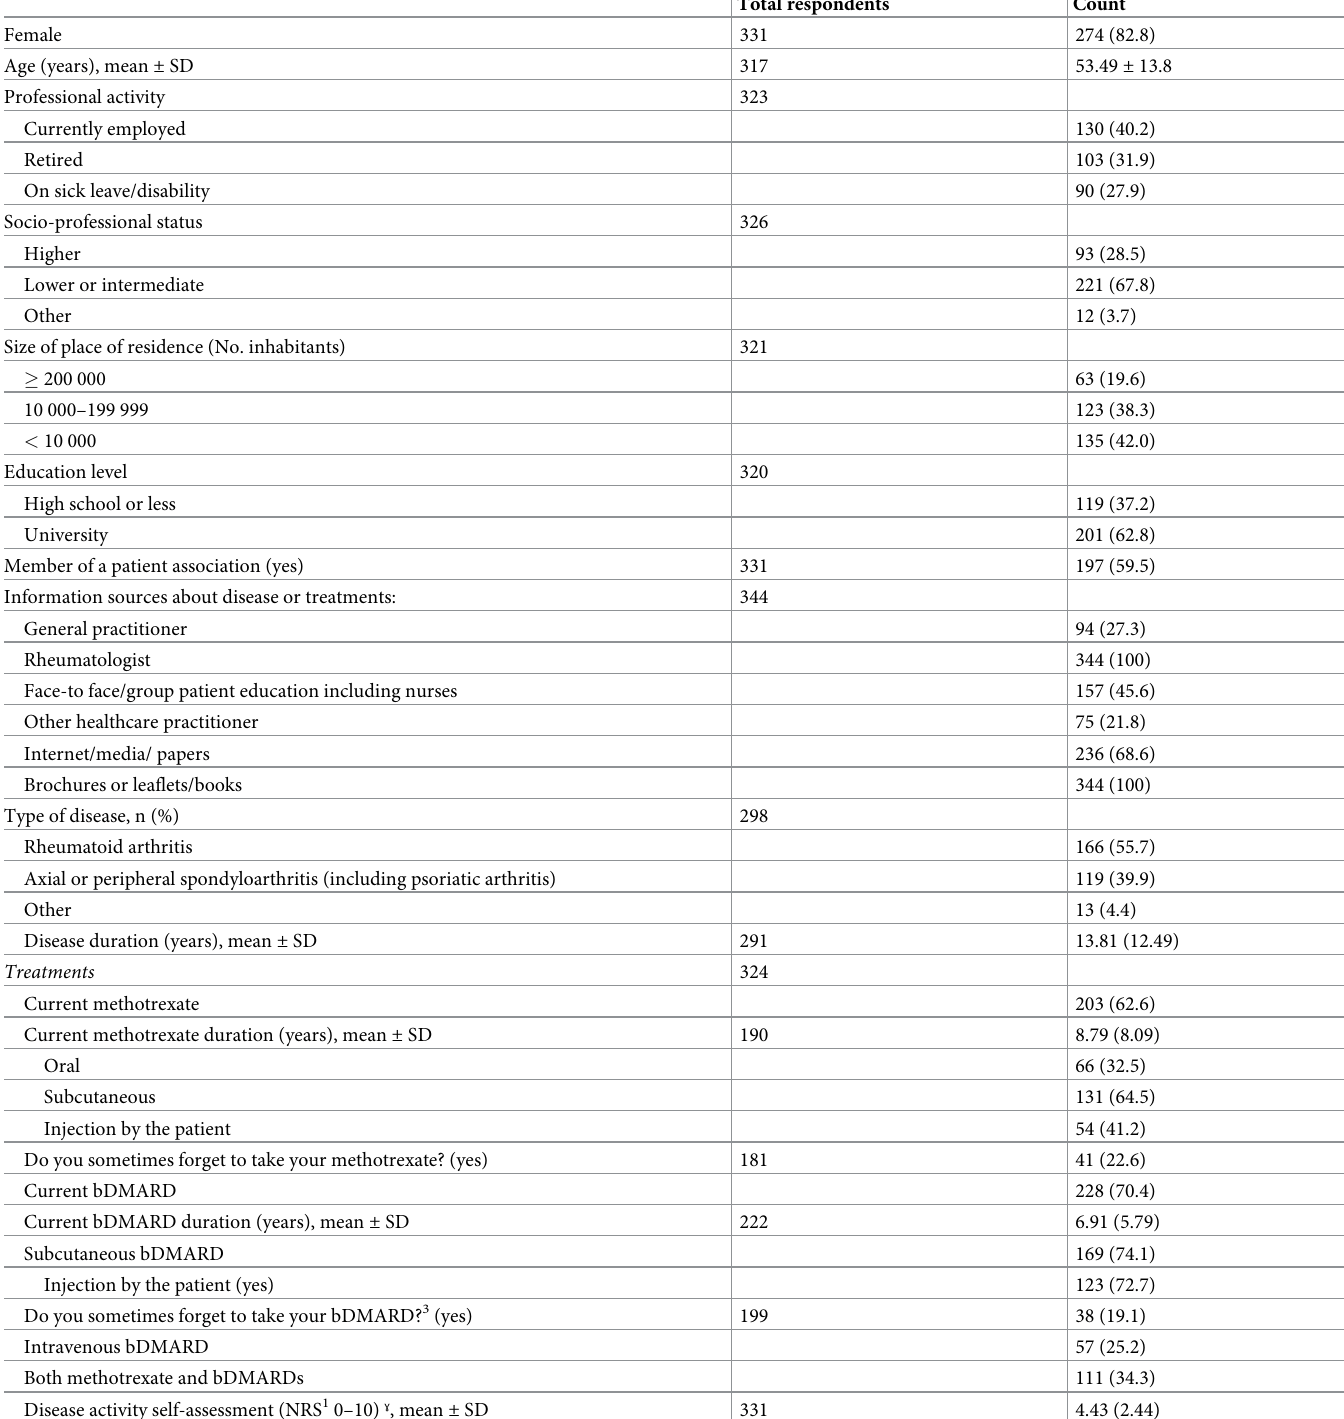
Table 1. Quantitative study. Patient characteristics: demographics, clinical features and other information (n = 344). The quantitative study was carried out from June to August